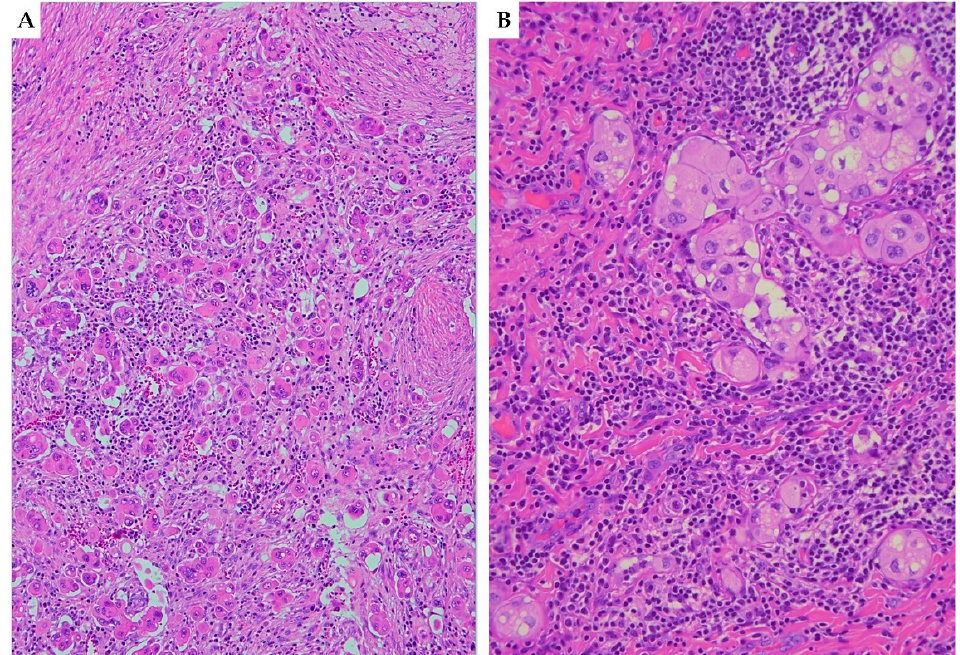
Figure 1. Haematoxylin and eosin (H&E) stained sections (( A ) 10×; ( B ) 20×) illustrating tumor-budding and cell nest size in squamous cell carcinoma of the cervix. ( A ) Cervical squamous cell carcinoma with high tumor-budding activity, characterized by numerous small tumor clusters of <5 cells present at the infiltrating edge of the tumor (×10). ( B ) Small-sized cell nests: cervical cancer showing cell nests consisting of 2–4 tumor cells with nested architecture (×20).